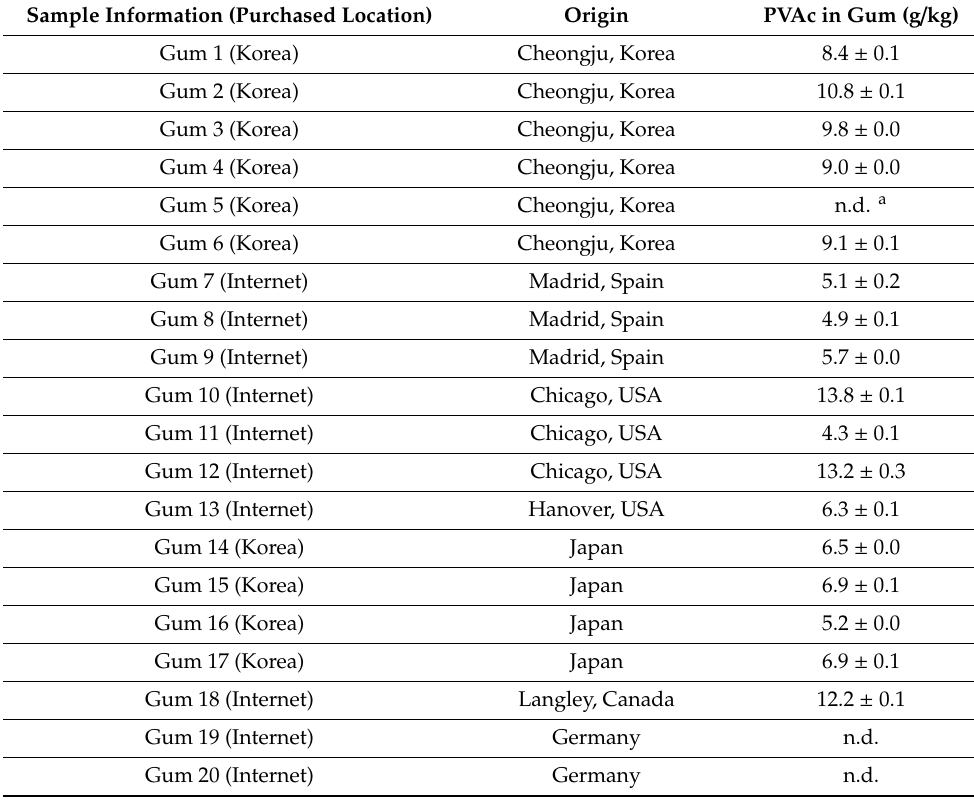
Table 3. Concentration of PVAc in chewing gum samples.